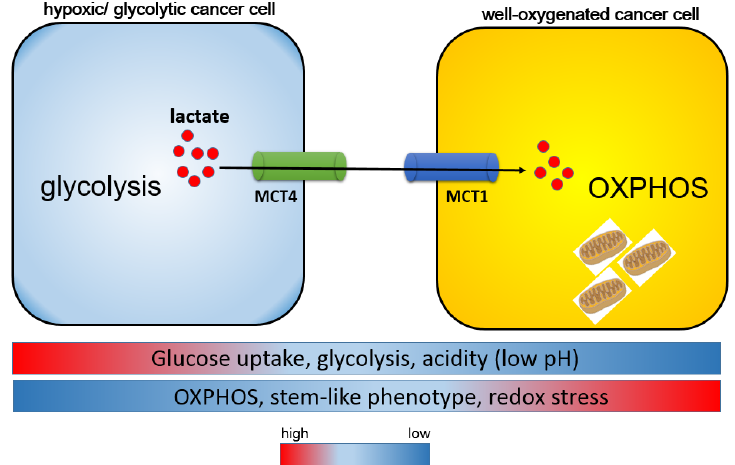
Figure 3. Harmonious interaction between MCT1 and MCT4 is responsible for the heterogeneity of cancer metabolism. Metabolic symbiosis occurs between well-oxygenated/aerobic cancer cells and hypoxic/glycolytic cancer cells. Intra-tumoral heterogeneity induces a lactate shuttle between hypoxic and oxidative cancer cells driven by both MCT1 and MCT4. In contrast to MCT1-expressing cancer cells, glucose uptake is robust in MCT4-positive cells. MCT4-positive hypoxic cells are responsible for the formation of an acidic tumor microenvironment through aerobic glycolysis and the secretion of lactate, whereas MCT1-positive oxidative cells utilize lactate as a metabolic intermediate for the tricarboxylic acid cycle (TCA cycle) and oxidative phosphorylation (OXPHOS), and consequently exhibit a stem-like phenotype.